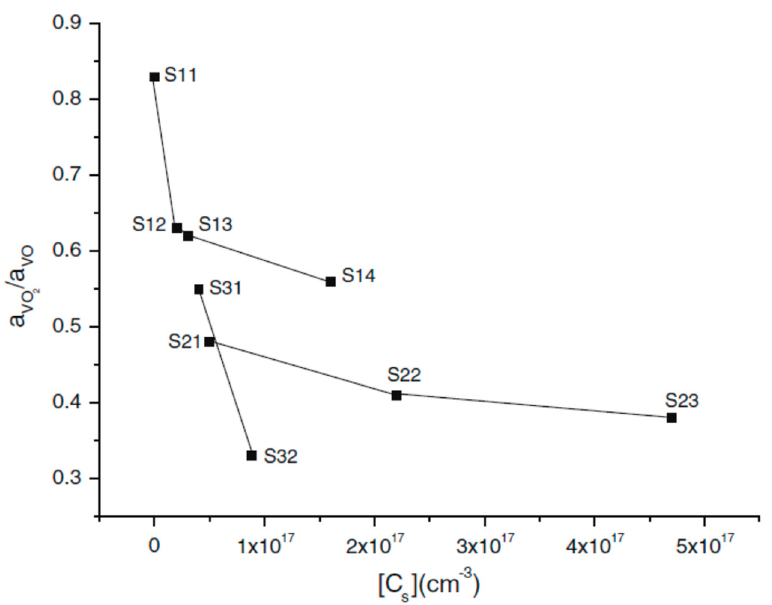
Figure 10. The conversion of the VO to VO 2 defect as a function of the C concentration in the Si samples. Reproduced with permission from [44].